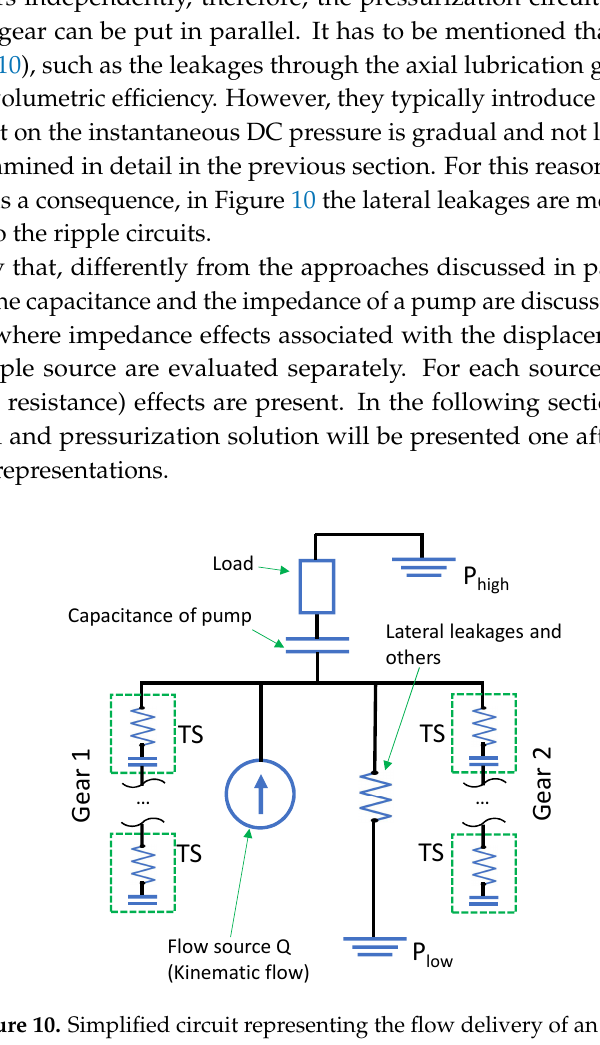
Figure 10. Simplified circuit representing the flow delivery of an